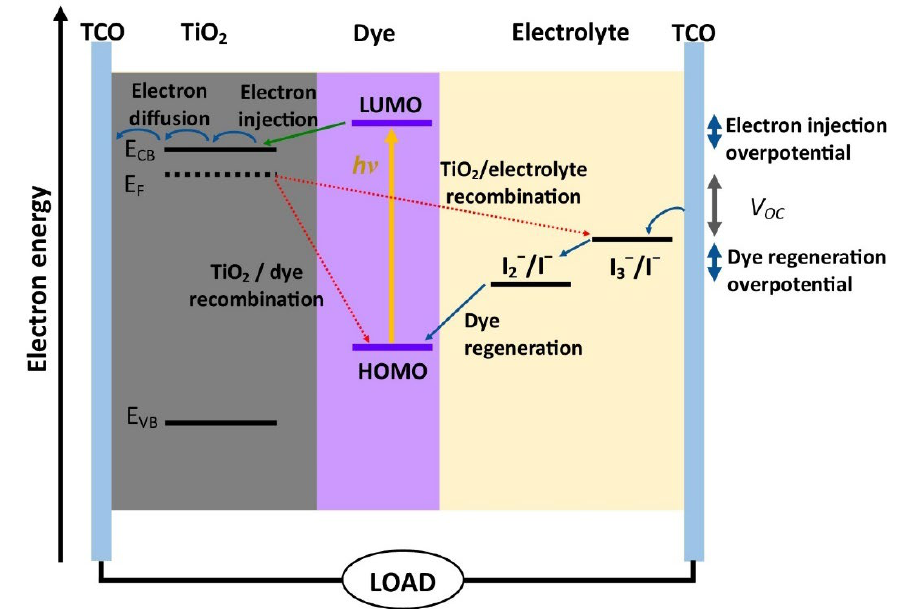
Figure 1. Schematic energy diagram and working mechanism of a DSSC.